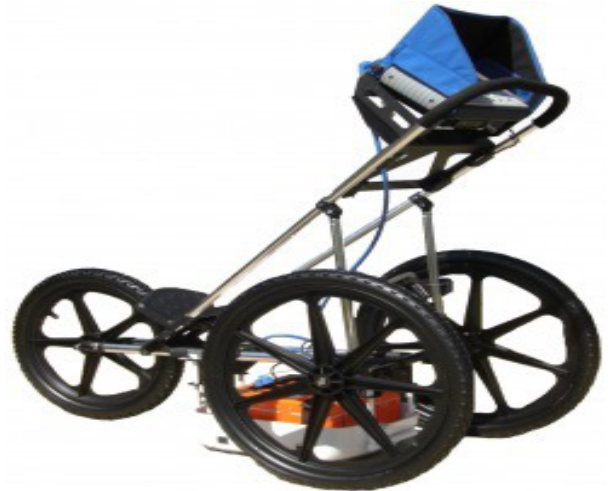
Figure 2. GPR Figure 2. GPR SIR3000. Figure 2. GPR SIR3000.